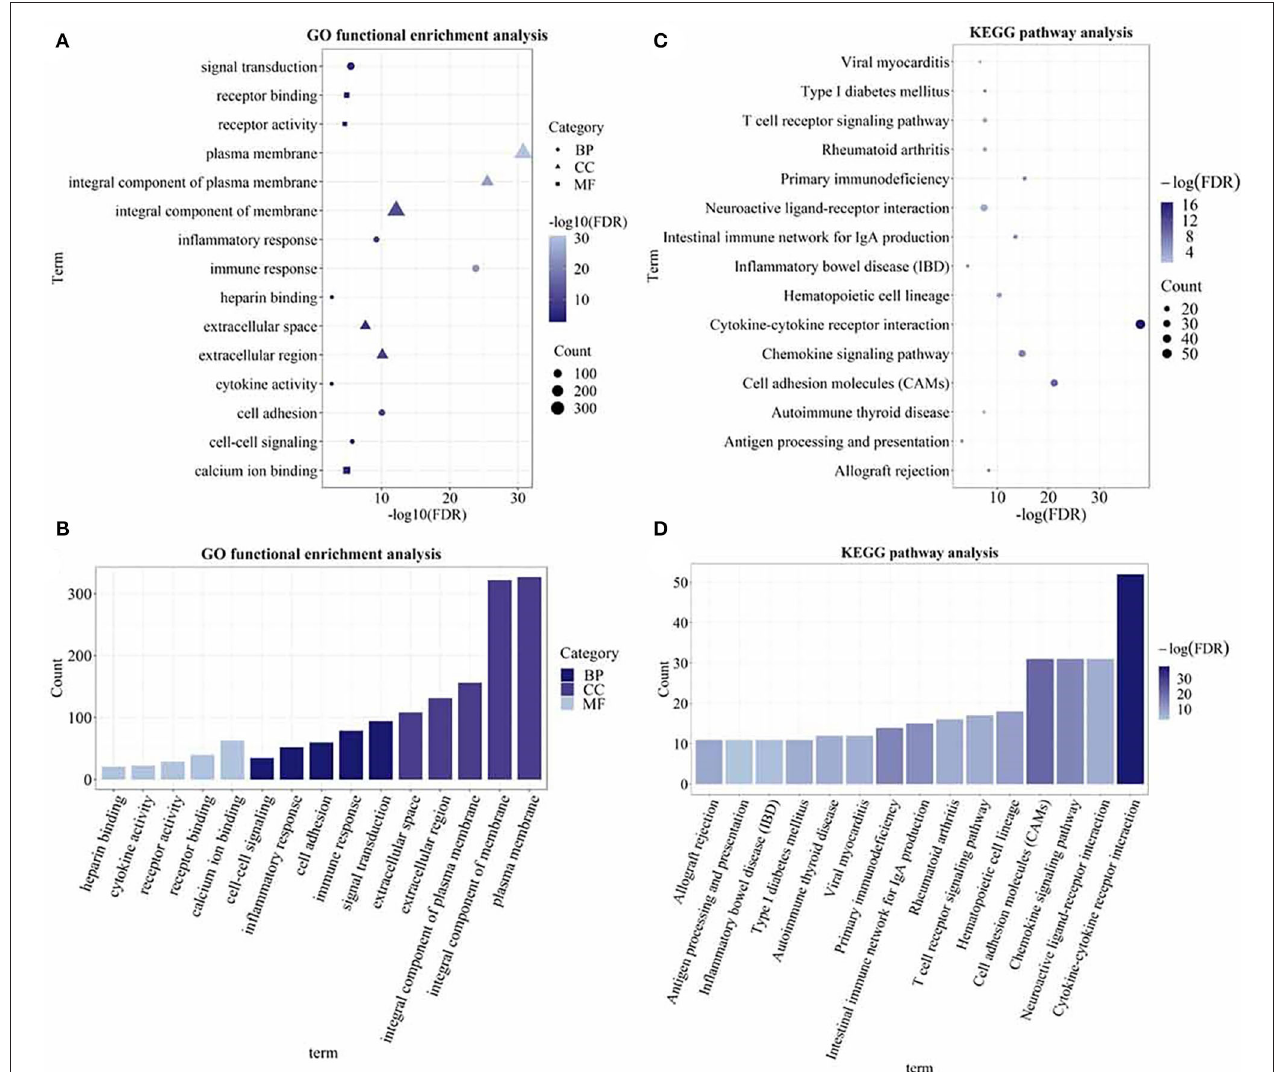
FIGURE 3 | The Gene Ontology (GO) functional enrichment and the Kyoto Encyclopedia of Genes and Genomes (KEGG) pathway analysis of the DEGs. (A) Dot plot of the GO functional enrichment analysis (the top five terms of each domain); (B) bar plot of the GO functional enrichment analysis (the top five terms of each domain); (C) dot plot of the KEGG pathway analysis; and (D) bar plot of the KEGG pathway analysis. The size of the dots and the height of the histogram represent the number of enriched genes and the color represents the P -value. The bigger the dot, the higher the column, and the more genes are enriched. The darker the color, the smaller the P